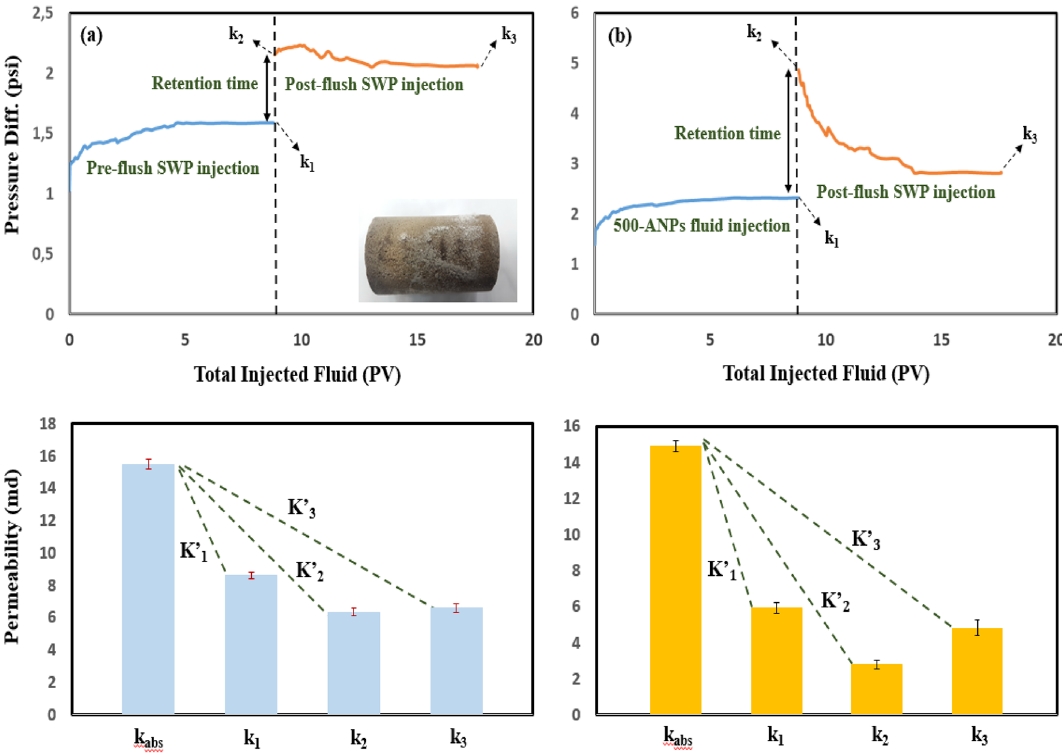
Figure 6. Differential pressure curves for fluid injection experiment in absence of oil for ( a ) core D’, SWP/ retention time/SWP ( b ) core D”, 500-PE-cit-ANPs nanofluid/retention time/SWP, retention time = 72